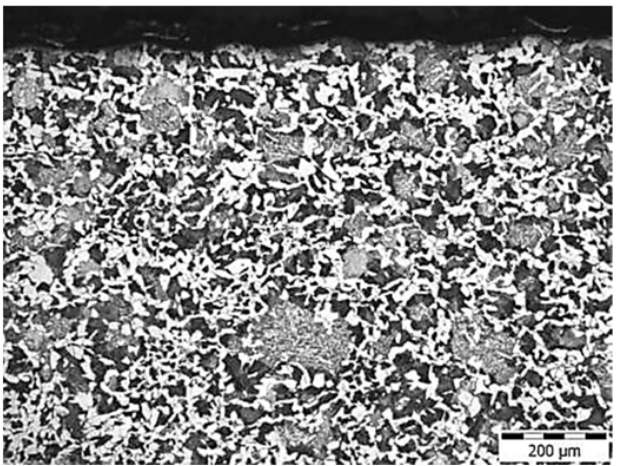
Figure 14. Microstructure in the subsurface area of CMnCr steel with 0.08 wt. % Bi.